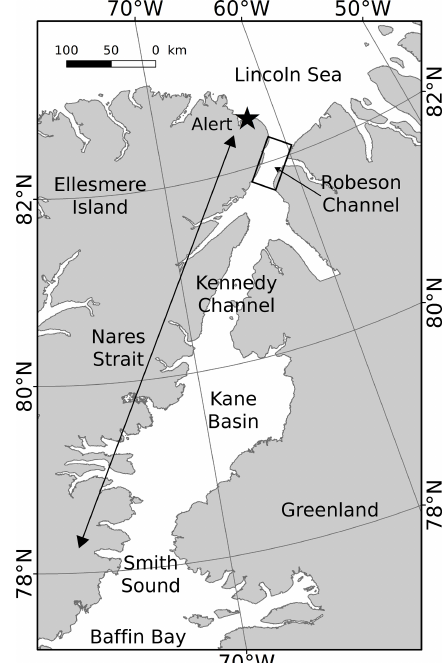
Figure 1. Map of the Robeson Channel and its surrounding areas. The Robeson Channel is located between Greenland and Ellesmere Island (Canada), with its northern location around 82 ◦ N, 60.5 ◦ W. It connects the Lincoln Sea to the Kennedy Channel, which opens into the Kane